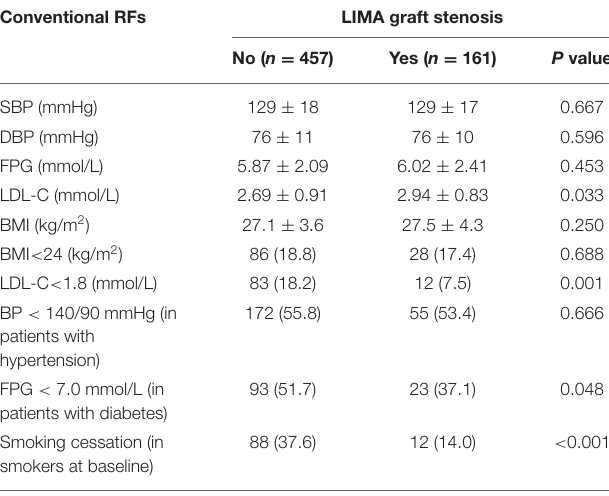
TABLE 1 | General characteristics of the study population. General characteristics